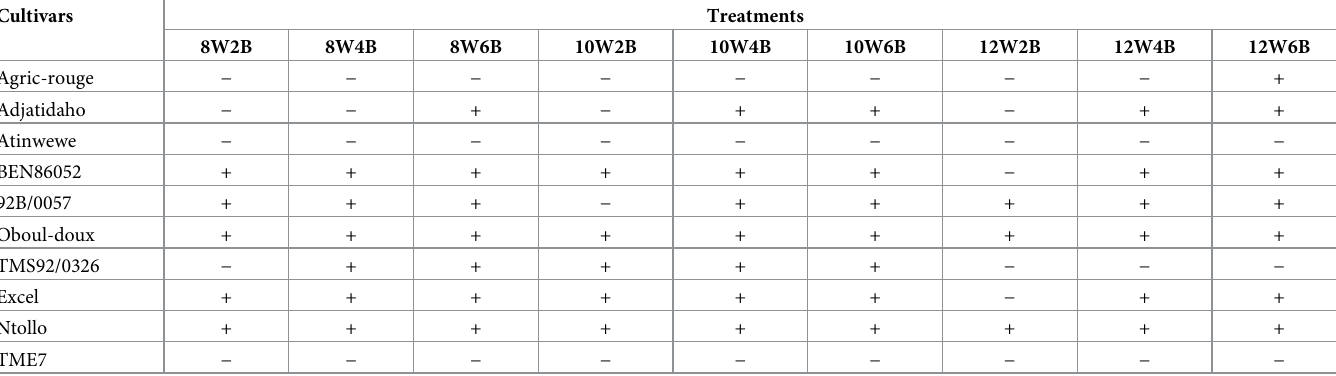
Table 2. Presence of ACMV in cultivars following inoculation. Cultivars